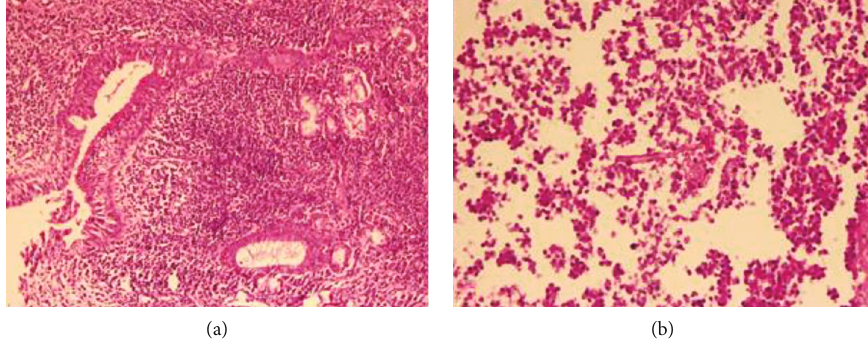
Figure 5: (a) Paranasal sinus mucosa with heavy in fi ltration of acute and chronic in fl ammatory cells, H&E stain ( × 100). (b) Paranasal sinus mucosa with the area of necrosis and hypha which are in favor of the zygomycetes group of fungi, surrounded by polymorphonuclear leukocytes, H&E stain ( ×